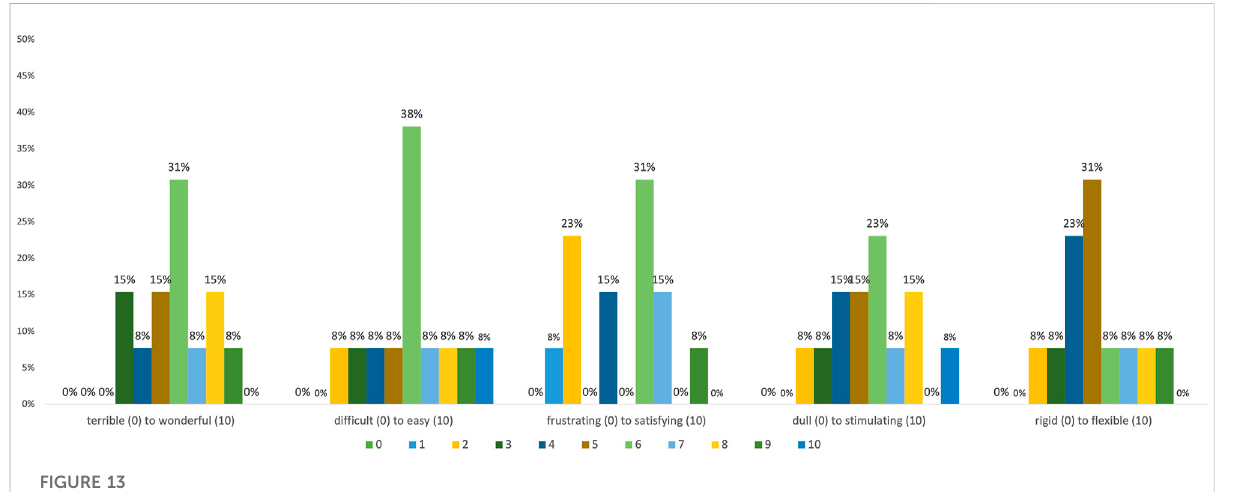
FIGURE 13 Functionality results. Rate from: (e.g., terrible (0) to wonderful